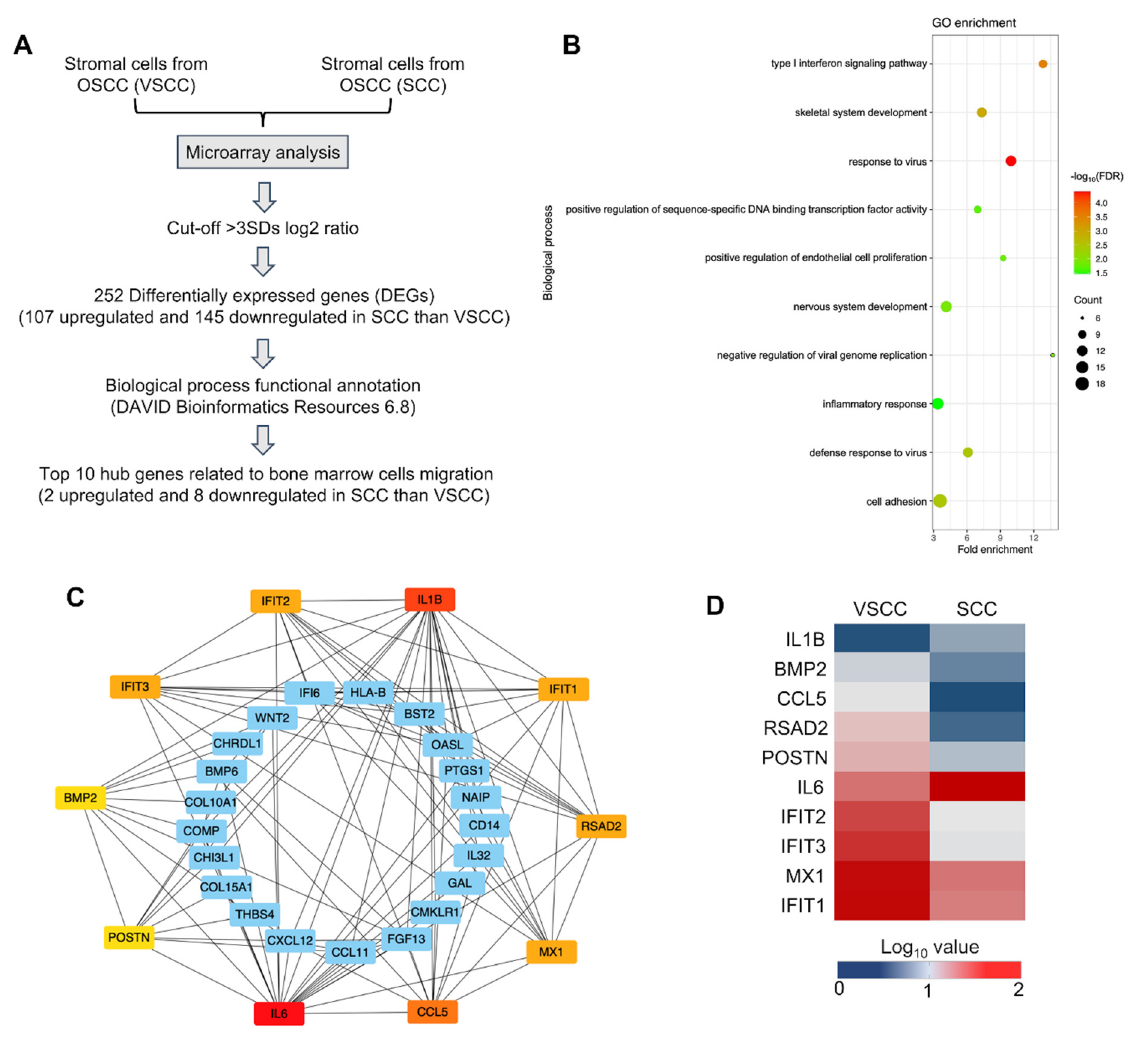
Figure 5. Identification of potential stromal factors involved in the relation of BMDCs and tumor invasion: ( A ) Flow chart of genes screening related to bone marrow cells migration; ( B ) The biological process enrichment analysis of common differentially expressed genes (DEGs) of VSCC stromal cells and SCC stromal cells; ( C ) Top 10 hub genes in bone marrow cells migration analyzed using protein-to-protein (PPI) network and Cytoscape software. ( D ) Heatmap presentation of the expression level of top 10 hub genes. VSCC, verrucous oral squamous cells carcinoma; SCC, conventional oral squamous cell carcinoma.